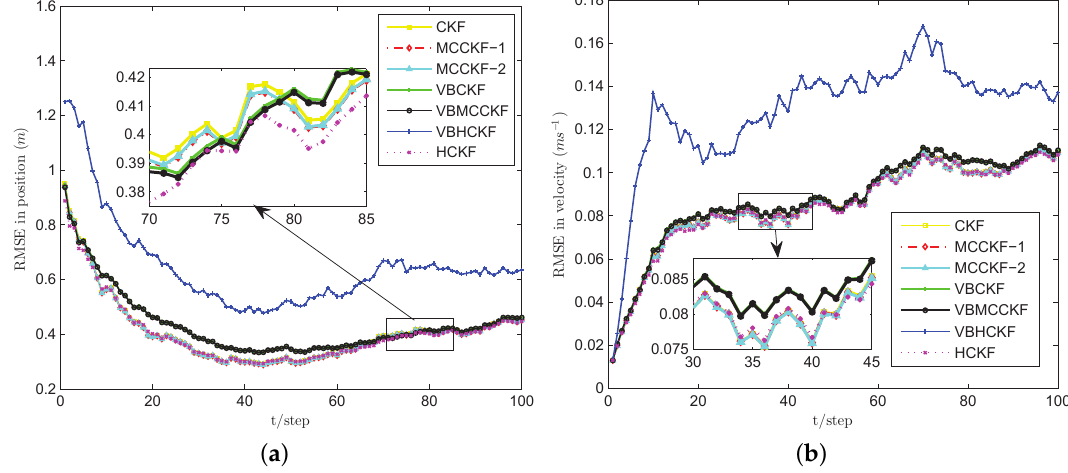
Figure 2. RMSE performances of different filters under Case A. ( a ) position; ( b )